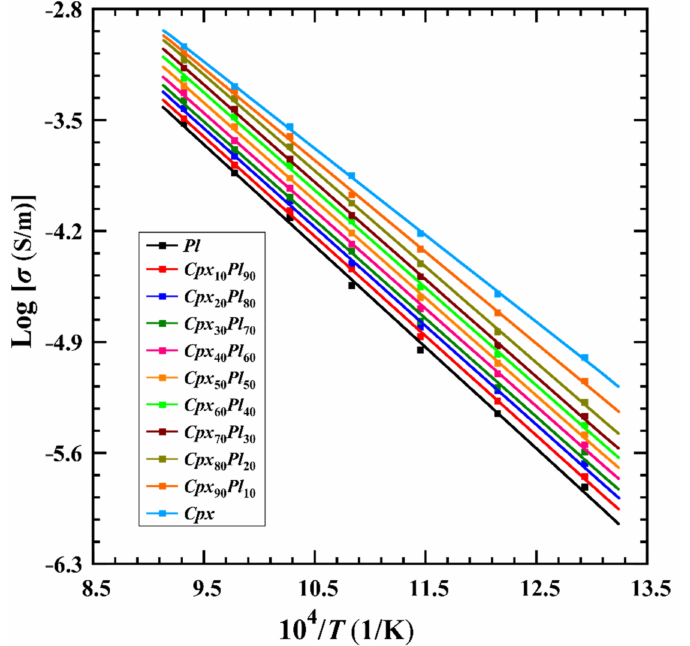
Figure 7. Logarithmic electrical conductivities of dry hot-pressed sintering gabbro with different miner- alogical proportions versus reciprocal temperature at temperature ranges of 773–1073 K and 1.0 GPa.